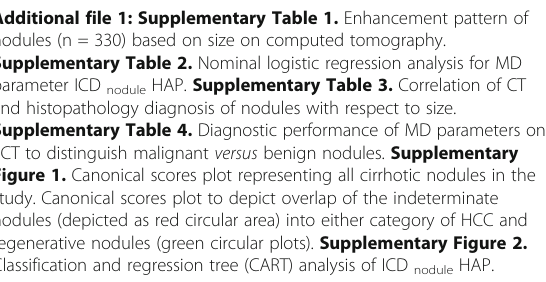
Supplementary Table 2. Nominal logistic regression analysis for MD parameter ICD nodule HAP. Supplementary Table 3. Correlation of